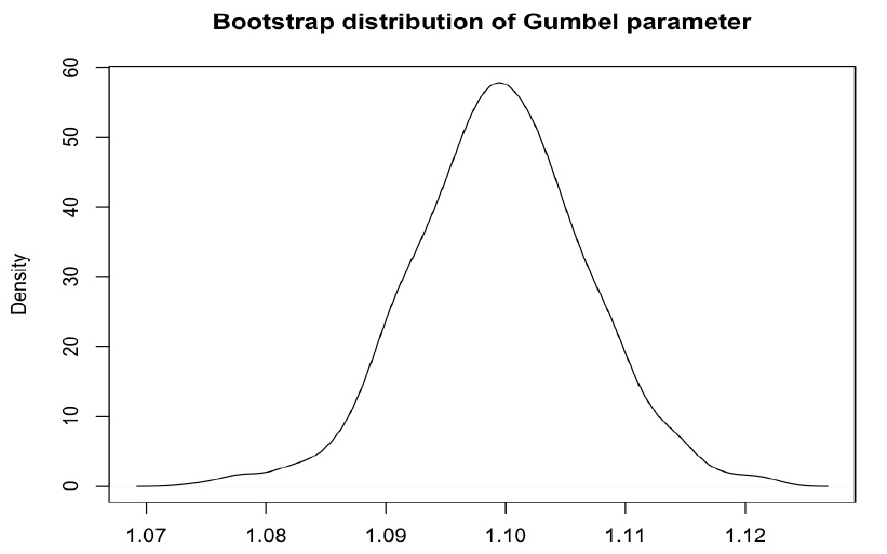
Figure 10. Normal distribution of the Bootstrap Gumbel